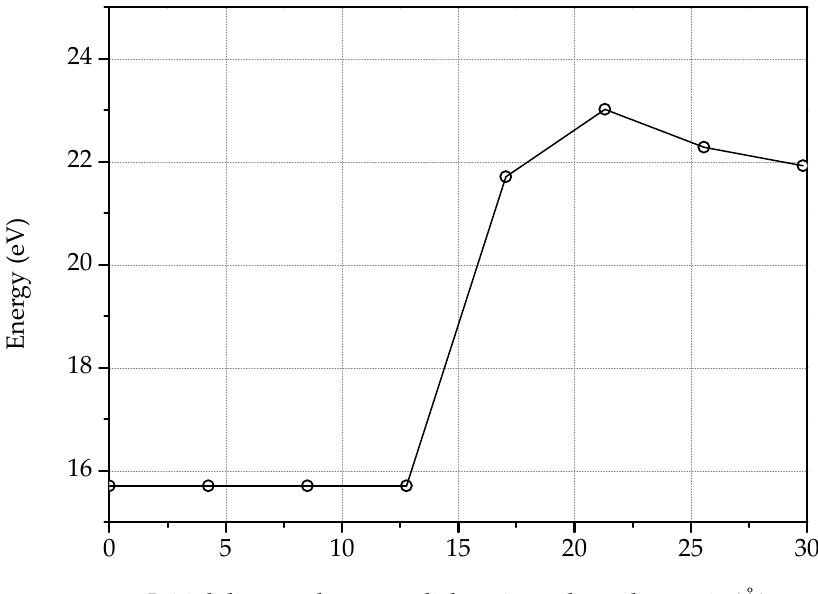
Figure 16. Energy of two n = 9 dipoles interacting through different layers in bilayer graphene, as a function of the initial distance between